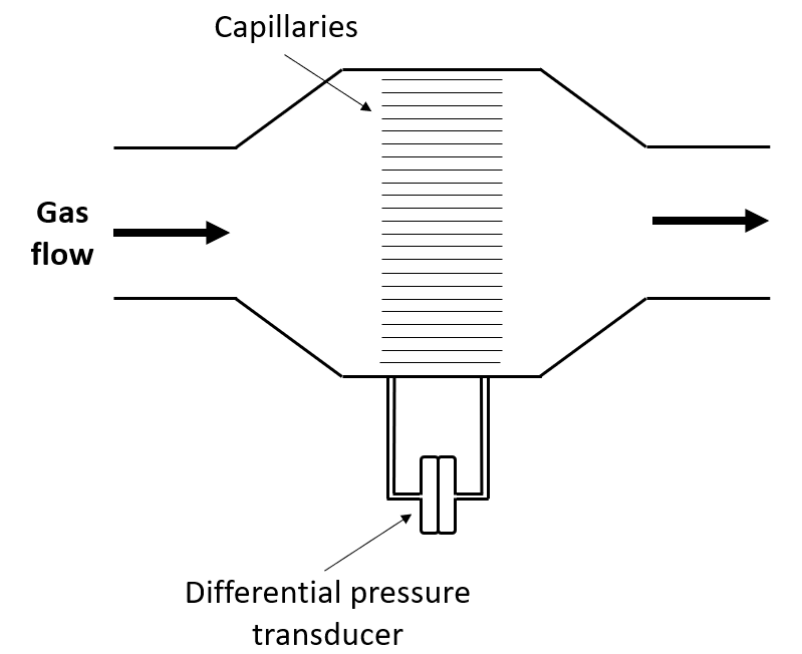
Figure 10. Schematic drawing of a Fleisch